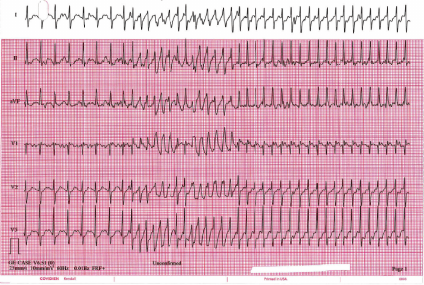
Figure 1: Electrocardiogram obtained during exercise stress test demonstrating sinus tachycardia at approximately 155 beats per minute (bpm). There is an abrupt onset of supraventricular tachycardia with intermittent aberrant conduction and a ventricular rate of 290 bpm. Standard paper speed is 25 millimeters per second, and amplitude is 10 millimeters per millivolt.